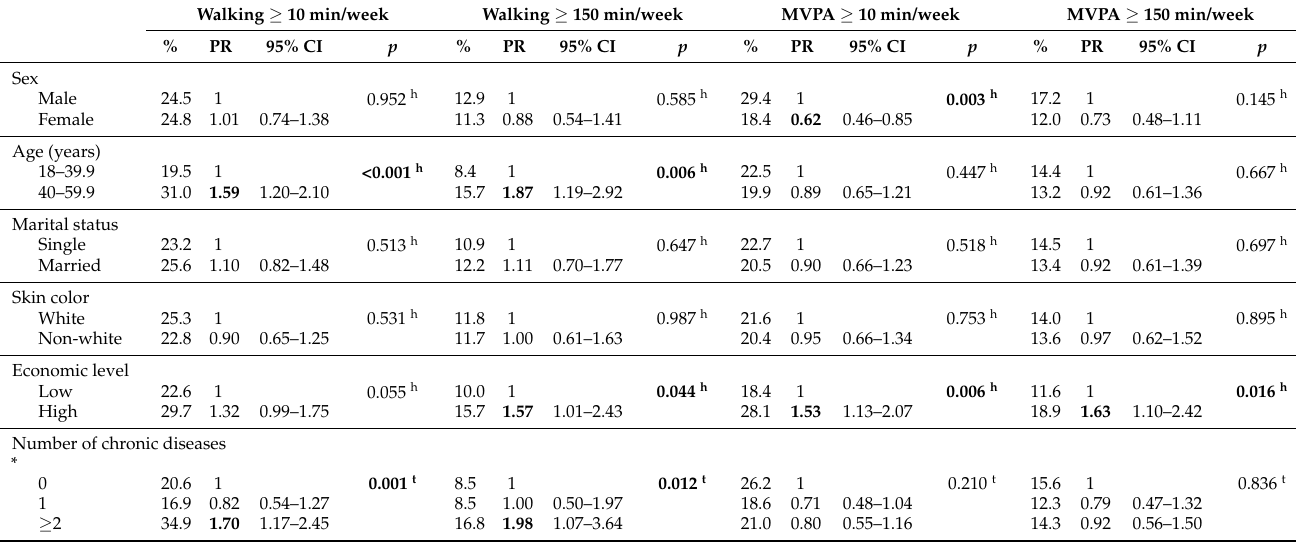
Table 2. The bivariate associations between sociodemographic characteristics, number of chronic diseases, and the leisure-time physical activity of adults in primary health care. S ã o Jos é dos Pinhais, Southern Brazil, 2019 ( n = 615).